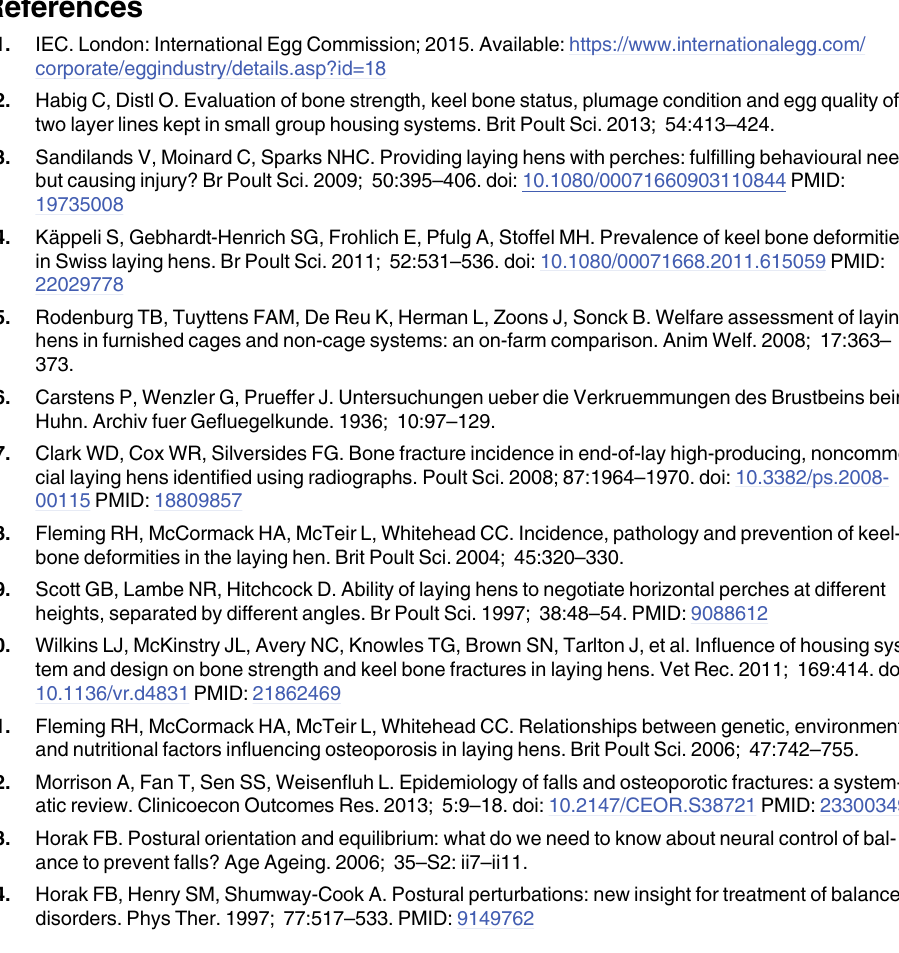
S2 Table. Summary of values of the underlying statistic (F), degrees of freedom (df) and p- values comparing the significant effect of perch state, health status, axis and their signifi- cant interactions ( (cid:1) ) on linear acceleration